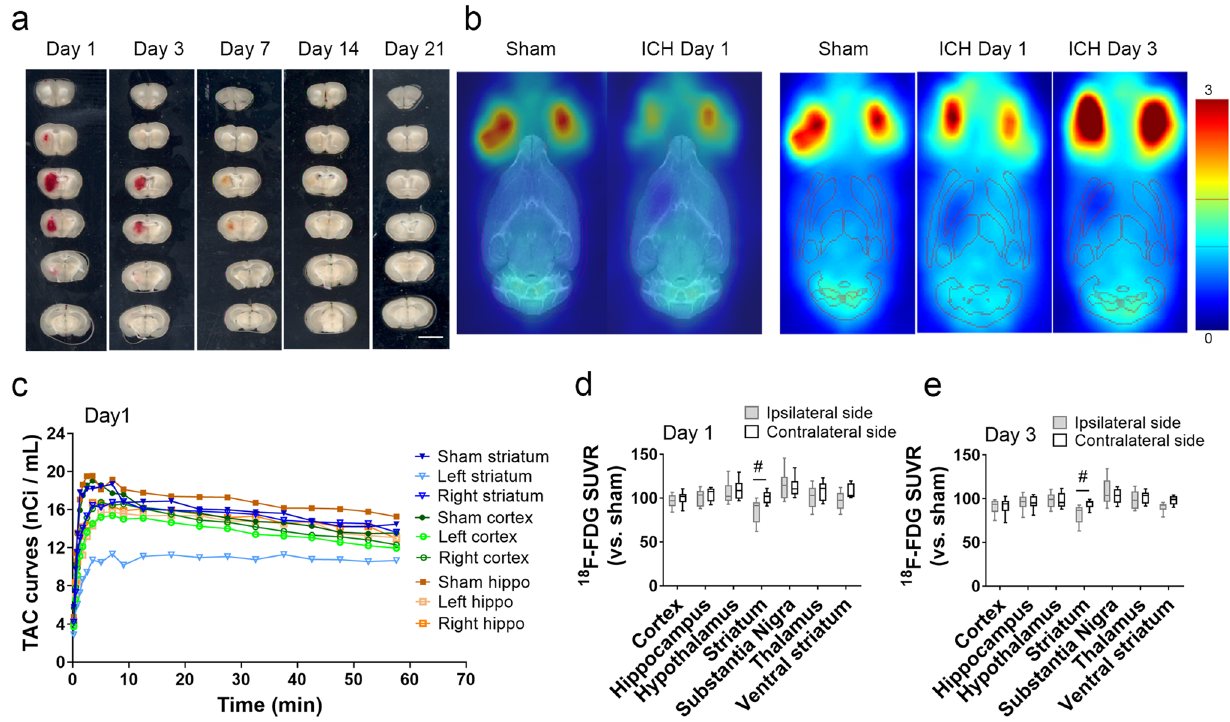
Figure 1. 18 F-FDG glucose uptake decreases in the ipsilateral striatum on days 1 and 3 after ICH. ( a ) Representative images of brain coronal slices show hematoma at different time points after collagenase- induced intracerebral hemorrhage (ICH). Brain slices were 1 mm thick. Scale bar: 500 µm. ( b ) Representative PET images of mice without (sham) or with ICH. Left panel: averaged PET images normalized to cerebellum (CB-ratio) for sham group and ICH group, fused with MRI reference template. Right panel: CB-ratio images fused with volume of interest (VOI) outlines to place brain regions. Red region shows nonspecific high activity area (blood in retro-orbital sinus). ( c ) Time activity curves (TAC) of striatum, cortex, and hippocampus (hippo) during 60 min of PET scanning on day 1 after ICH. n = 3. Each symbol represents the mean at that time point. ( d , e ) Average 18 F-FDG standardized uptake value ratio (SUVR) at 40–60 min of PET scan on day 1 ( d ) and day 3 ( e ) after ICH. n = 9; # p < 0.05. Two-way ANOVA by hemisphere and brain region followed by Bonferroni post hoc test. Results are presented as box-and-whisker plots (the middle horizontal line within the box represents the median, boxes extend from the 25th to the 75th percentile, and the whiskers represent 95% confidence